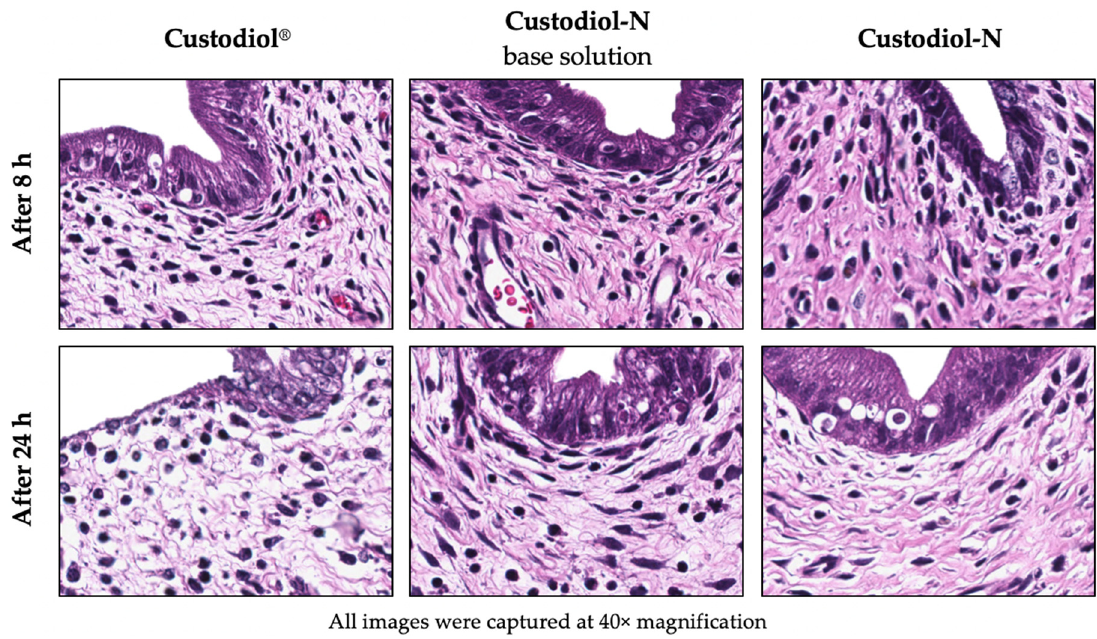
Figure1. E ff ectsofdi ff Figure 1. Effects of different preservation solutions on uterus SCS damage in H&E stained tissue samples.